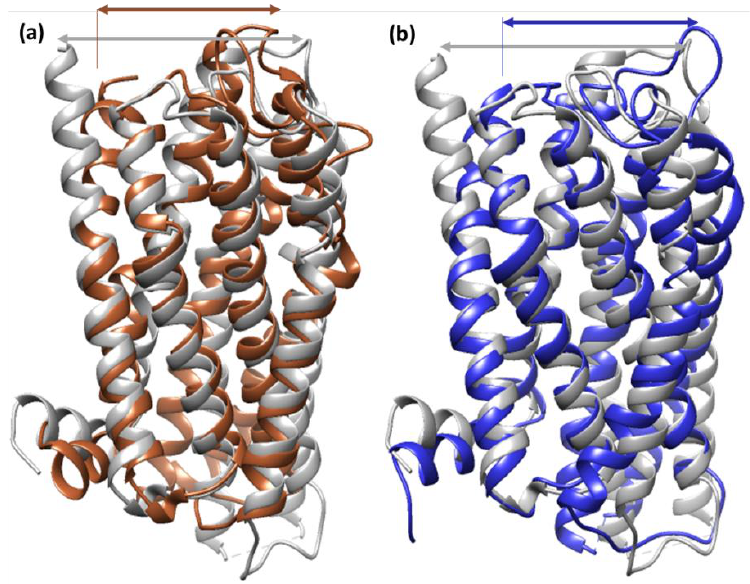
Figure 11. Superimposed simulation structure of ( a ) unbounded serotonin receptor (gray) and [(FXN)(PA)] – serotonin (brown); ( b ) unbounded serotonin receptor (gray) and (FXN) – serotonin (blue). The standard deviation and average distance between each pair of amino acids for each conformation were displayed using RR distance maps (Figure 12) [39,40].